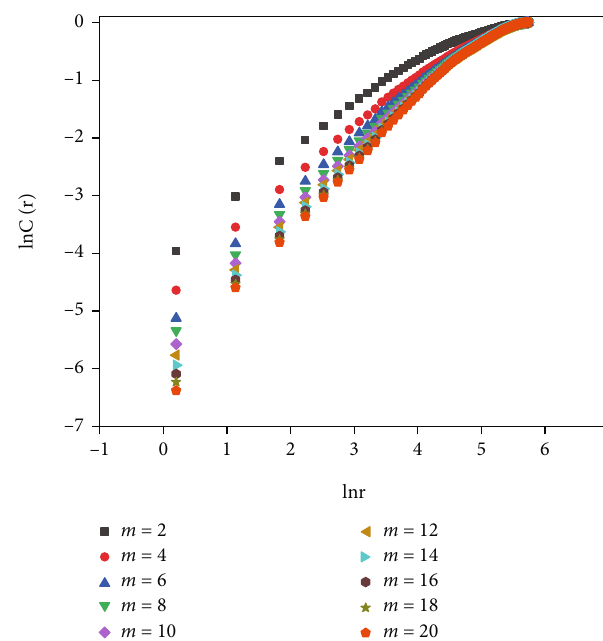
Figure 11: The ln C ð r Þ − ln r correlation for di ff erent m values.